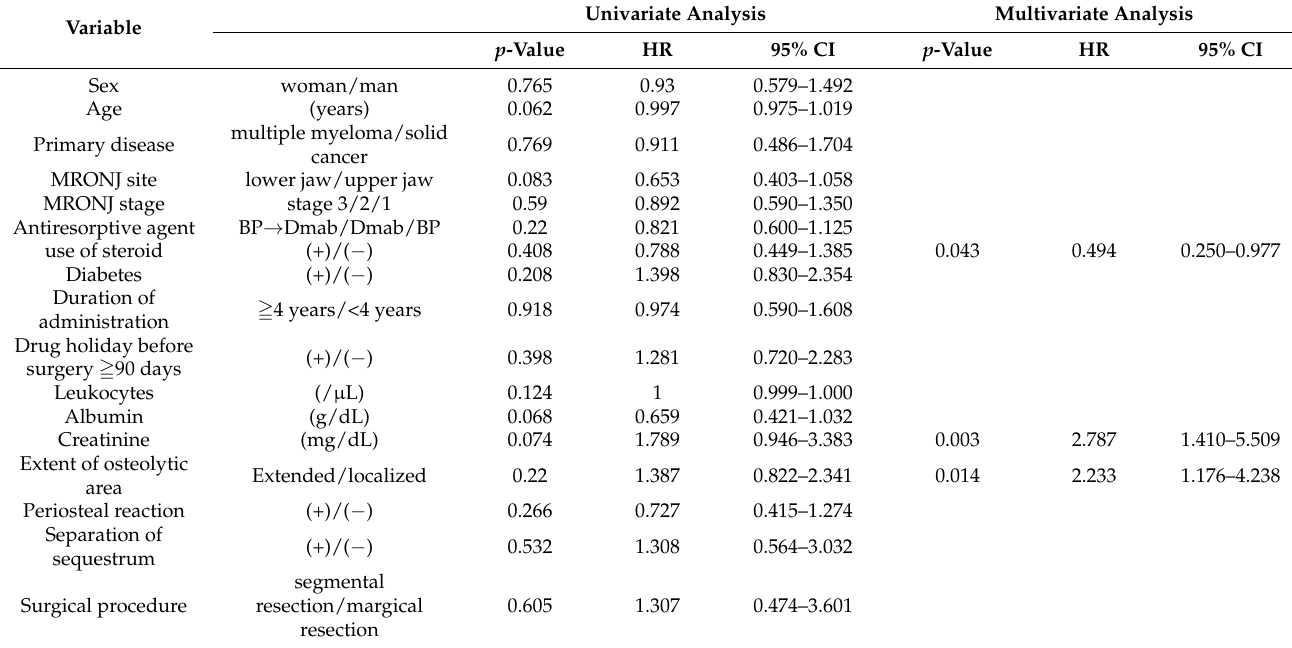
Table 3. Relationship between each variable and treatment outcome (univariate and multivariate cox